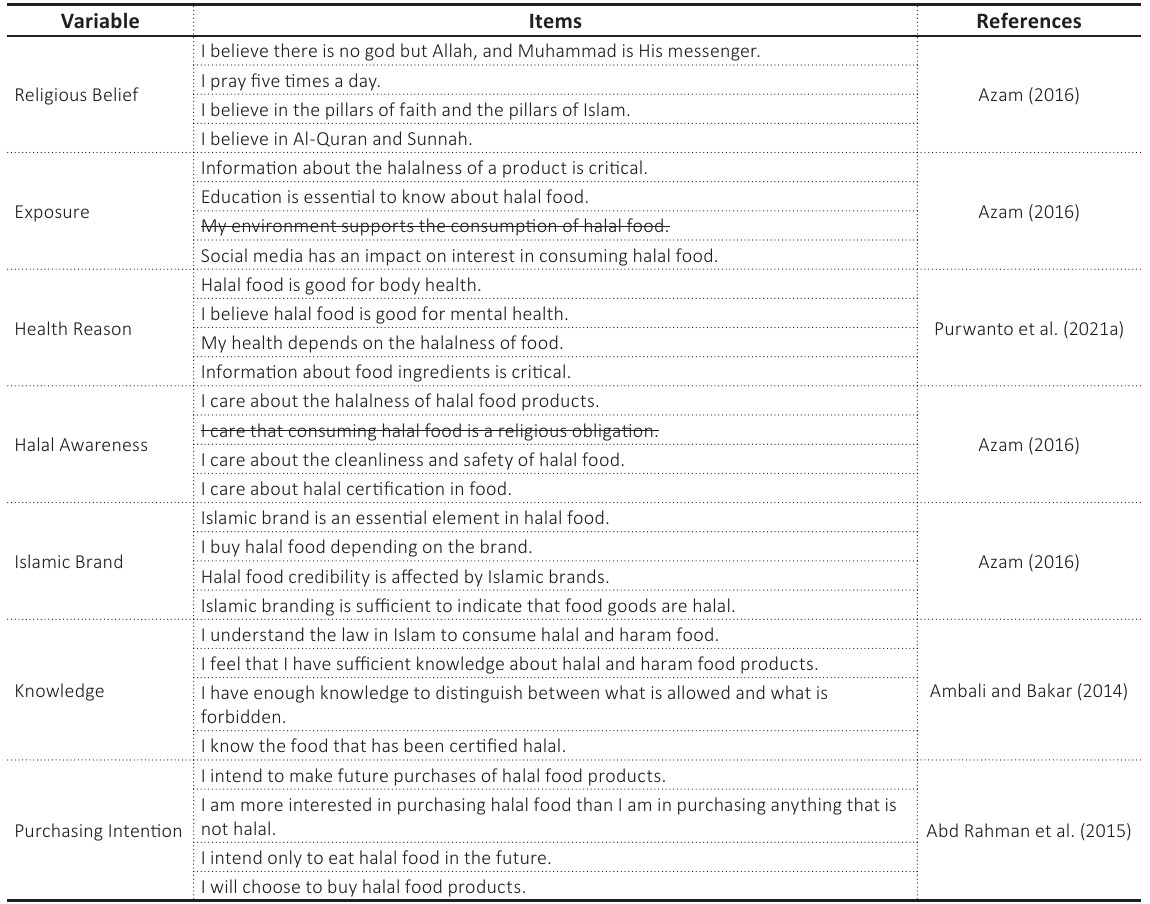
Table 1. Research constructs and their relative